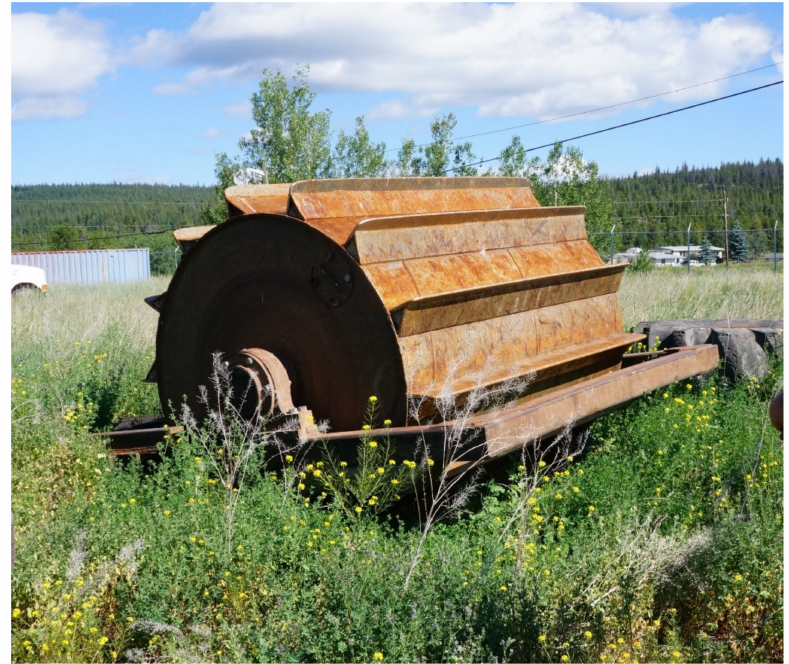
Figure 7. Example of a roller–chopper machine for treating postharvest